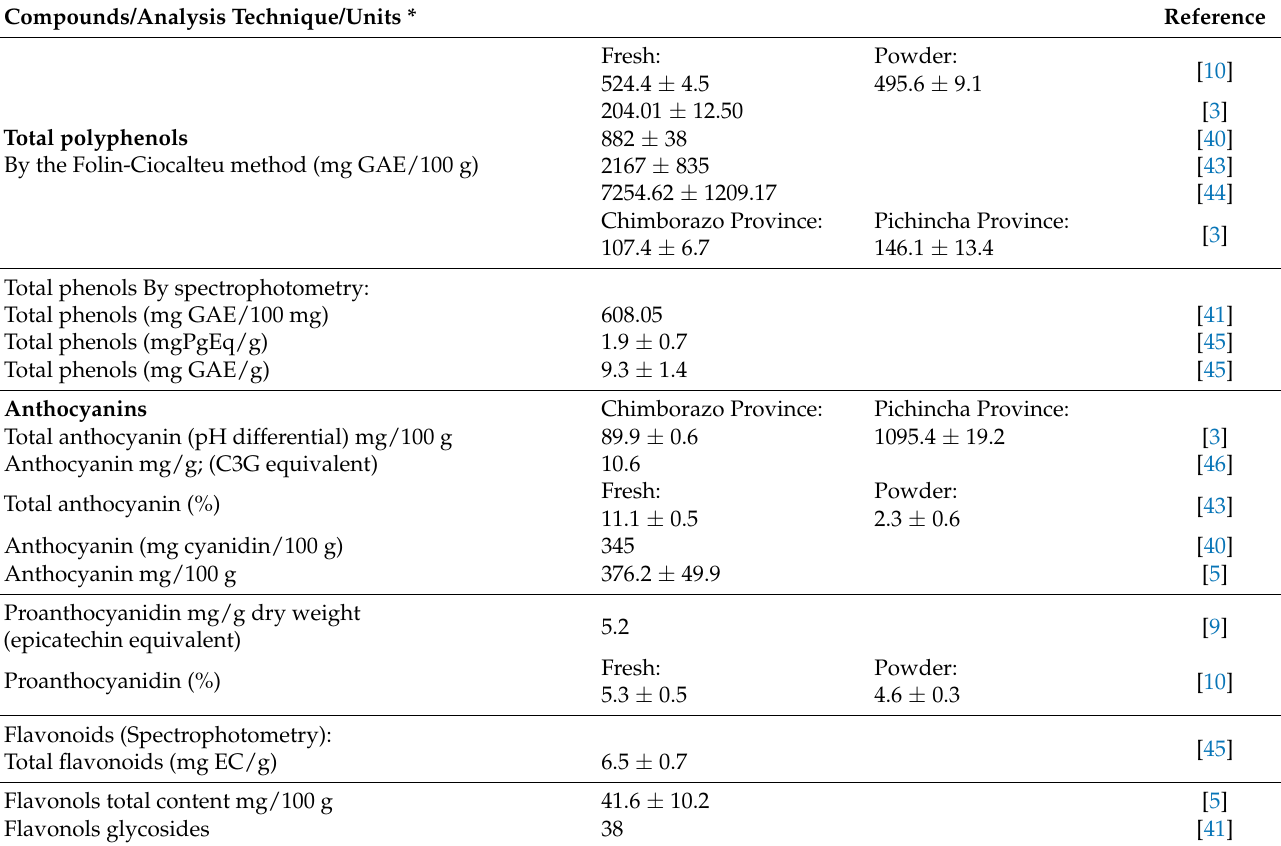
Table 2. Bioactive compounds from Vaccinium floribundum